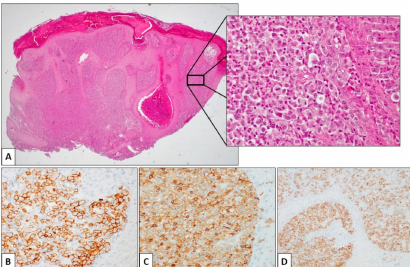
Figure 1. Histological features of primary cutaneous anaplastic large cell lymphoma (pcALCL). ( A )